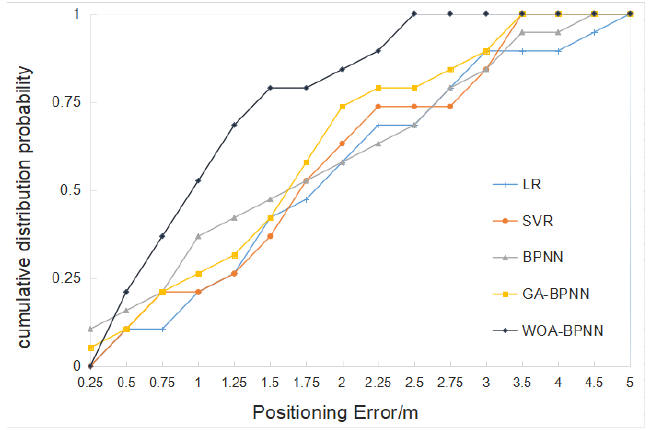
Figure 20. Cumulative distribution function (CDF) of positioning error.